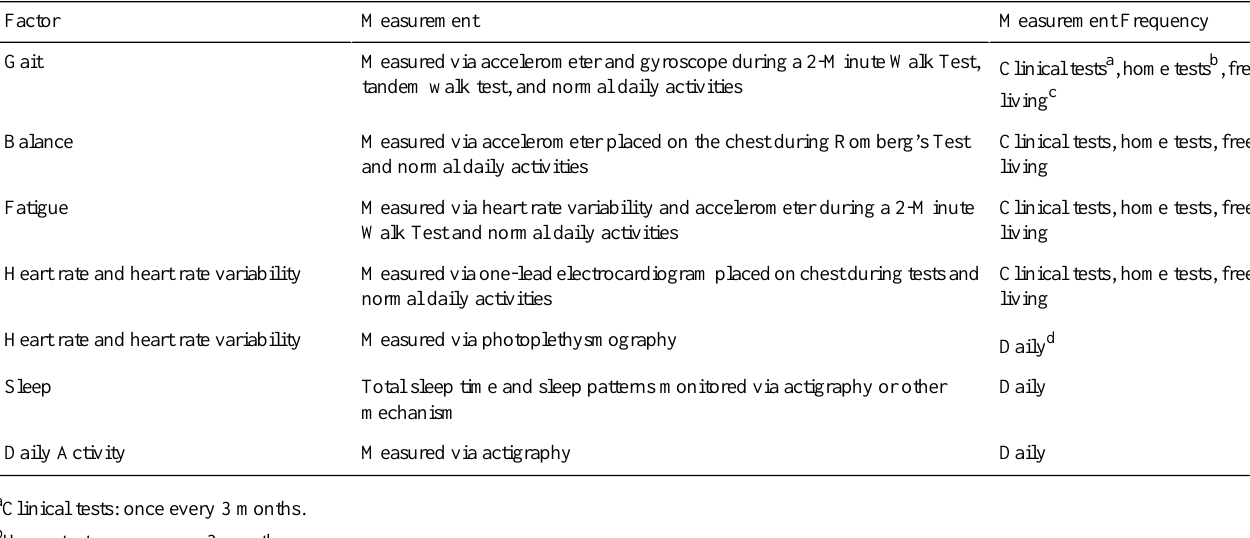
Table 1. Device-based remote measurement scheme for the RADAR-CNS multiple sclerosis